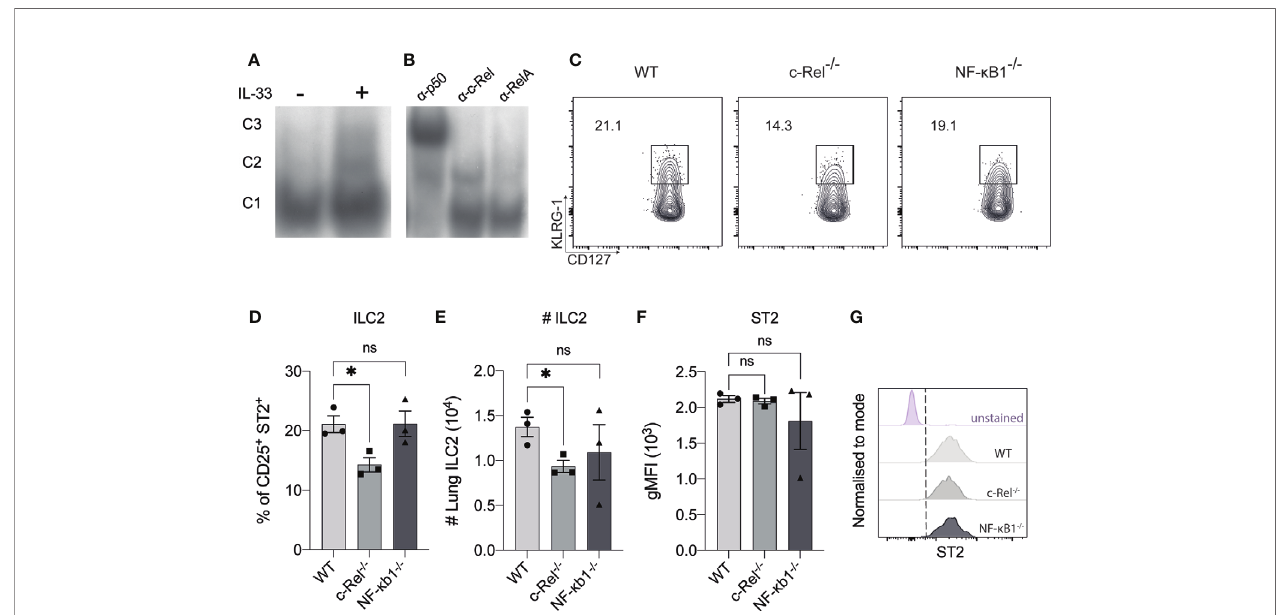
FIGURE 1 | The presence of canonical NF- k B activity in ILC2s. (A) Electrophoretic mobility shift assay (EMSA) analysis in IL-33-stimulated BM-derived ILC2Ps. (B) The speci fi c members of NF- kb were detected via antibody supershift analysis by using speci fi c antibodies against p50, cRel and RelA. C1 is composed of p50, C2 is composed of RelA and C3 is composed of c-Rel protein. (C) Representative fl ow cytometry plot of CD127 + KLRG-1 + lung ILC2s (gated on viable CD45 + Lin - CD90 + CD25 + ST2 + cells) from WT, c-Rel -/- and NF- k B -/- naive mice. (D) Quanti fi cation of lung ILC2 among parent CD25 + ST2 + cells. (E) Absolute numbers of lung ILC2s per animal. (F) Quanti fi cation of ST2 in ILC2s, expressed as geometric mean fl uorescence intensity (gMFI). (G) Representative histogram plots of ST2 expression in ILC2s. All plots and graphs are representative of at least two independent experiments with at least three mice per group. Error bars represent ± SEM. *p ≤ 0.05. ns, non-signi fi